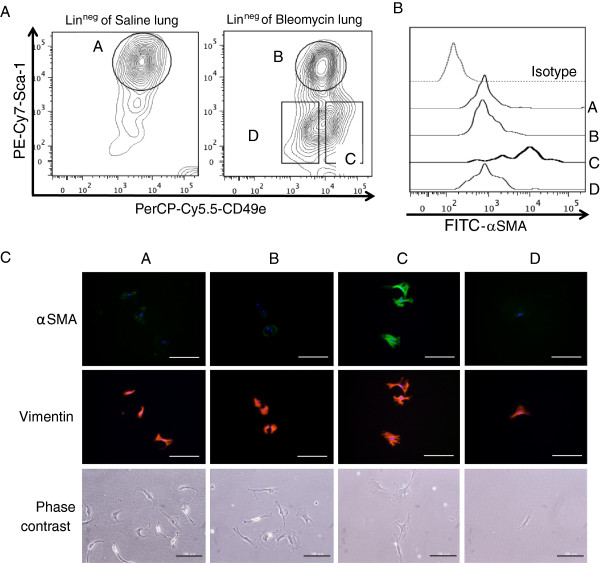
Identification of myofibroblast-rich and fibroblast-rich populations. (A) Flow cytometry plots showing the expression of CD49e (x-axis) and Sca-1 (y-axis) of linneg cells of saline-treated lungs (left) and bleomycin-injured lungs at day 12 (right). Linneg Sca-1high of saline-treated lungs (population A) and bleomycin-injured lungs at day 12 (population B) are indicated as circles. Linneg Sca-1low CD49ehigh of bleomycin-injured lungs at day 12 (population C) and linneg Sca-1low CD49elow of bleomycin-injured lungs at day 12 (population D) are indicated as oblongs. Figures show representative results. (B) Histogram showing the expression levels of intracellular α-SMA of populations A, B, C, and D using FITC-conjugated anti-α-SMA antibody. As a control, FITC-conjugated isotype control antibody was used. Figures show representative results. (C) Sorted cells from populations A, B, C, and D were grown for 36 h, fixed in 4% paraformaldehyde, and subjected to immunocytochemistry using anti-α-SMA antibody (green), anti-vimentin antibody (red), and DAPI (blue). Phase-contrast images of living cells are shown in lower panels. Figures show representative results. Scale bars indicate 100 μm. DAPI, 4′,6-diamidino-2-phenylindole.